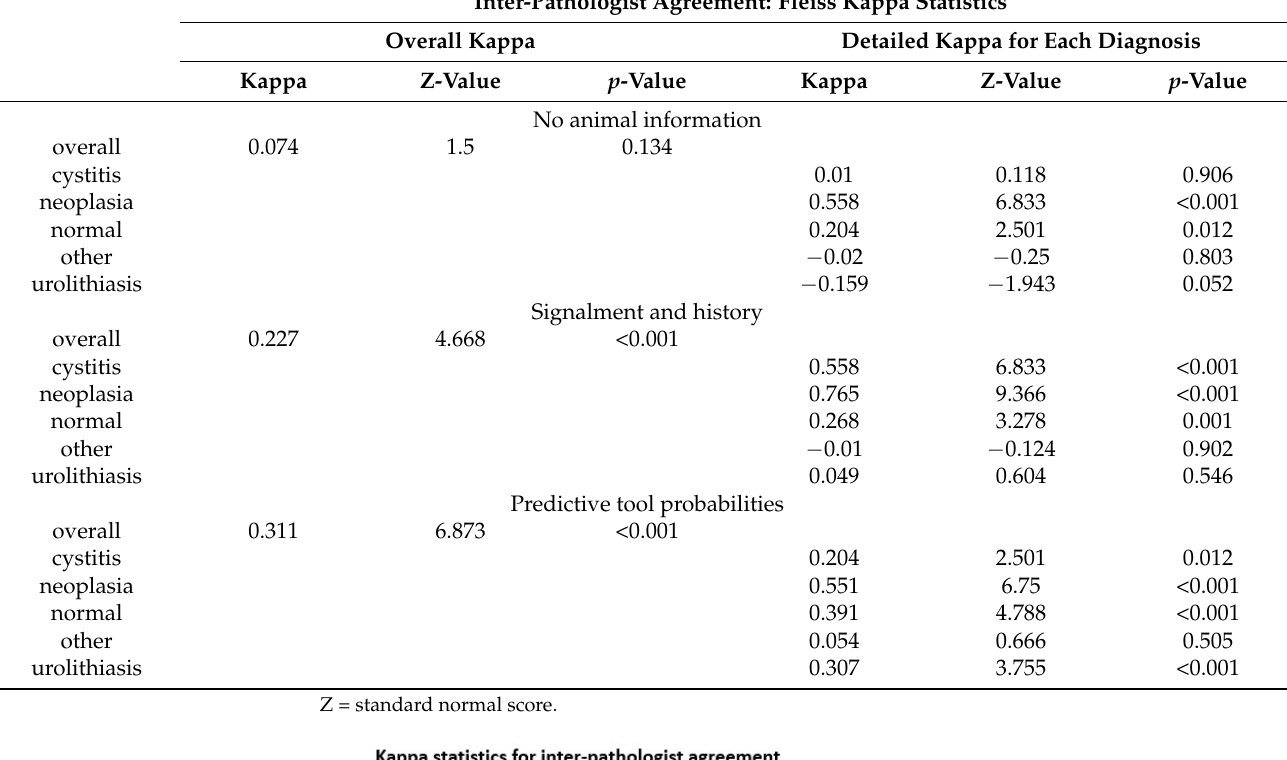
Table 5. Inter-pathologist agreement for the three slide-reading conditions, diagnosing digital whole- slide images of canine and feline bladder tissue.